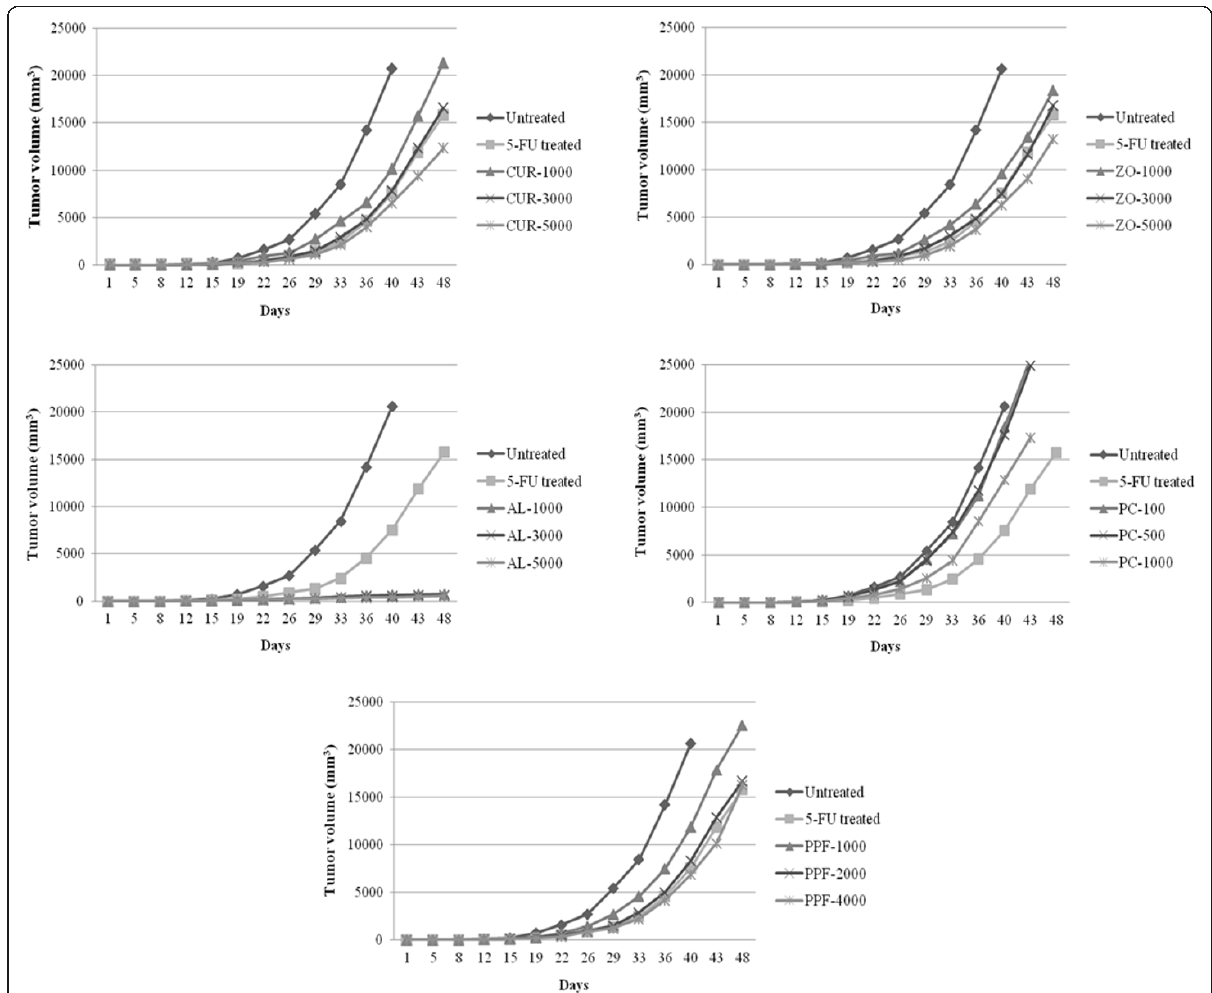
Figure 1 Anti-CCA activities indicated by inhibitory action on tumor volume (mean ± SEM: mm 3 ) of CUR compound and extracts of ZO, AL, PC, and PPF at various dose levels, in comparison with NSS (untreated control) and 5-FU (reference control) in CCA- xenografted nude mice during the 48 days investigation period . Statistically significant difference by ANOVA, followed by post hoc scheffe test: AL-treated group at low dose level vs. control group (p < 0.001). AL-treated group at medium dose level vs. control group (p < 0.001). AL- treated group at high dose level vs. control group (p < 0.001). CUR-treated group at high dose level vs. control group (p < 0.01). ZO-treated group at high dose level vs. control group (p < 0.01). PPF-treated group at high dose level vs. control group (p < 0.01). PC-treated group at high dose level vs. control group (p <